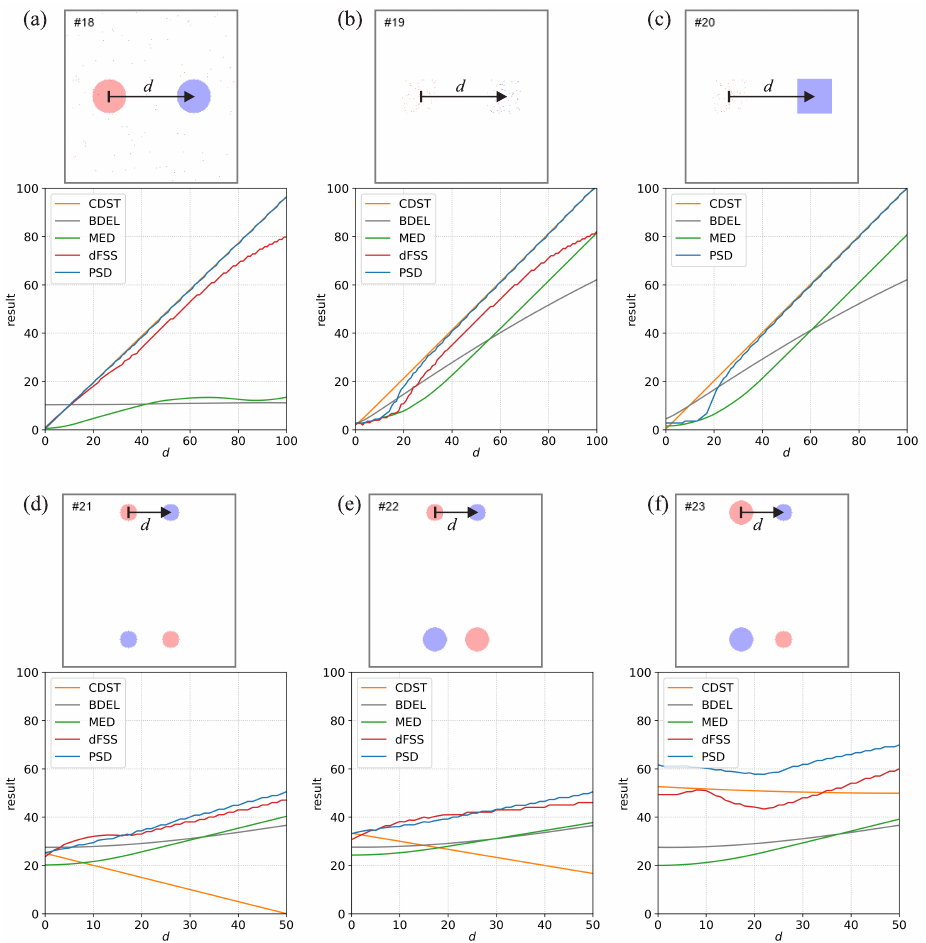
Figure 4. Same as Figure 1 but for noisy, scattered and two-set event